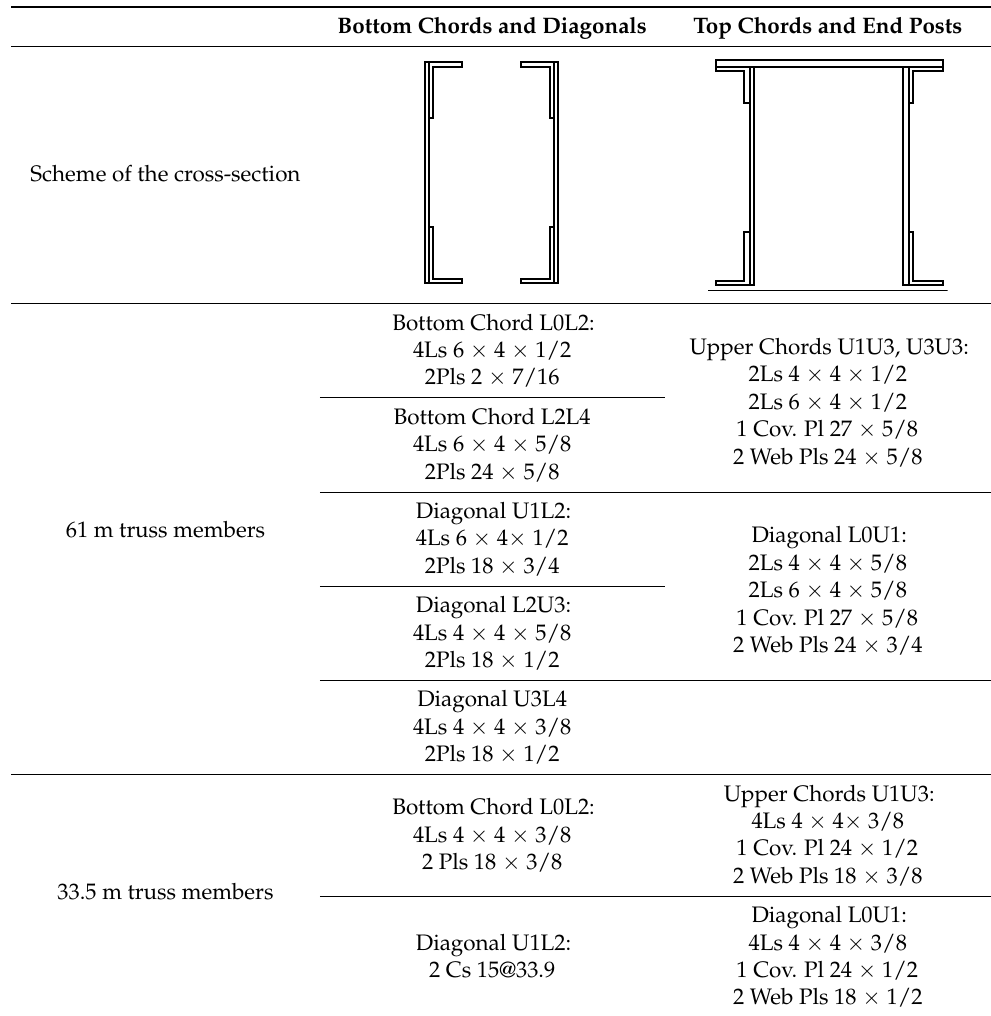
Scheme of the cross-section